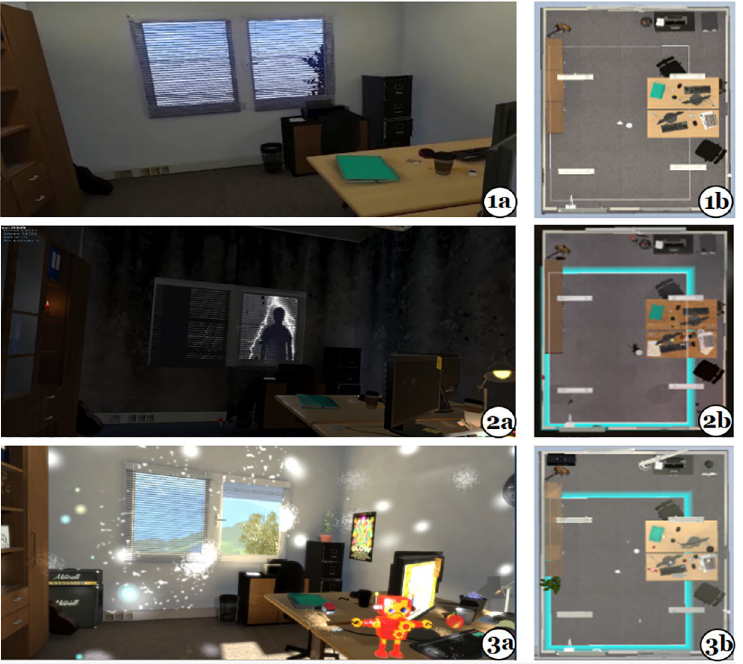
Fig 1. Screenshots of the three affective VEs from the user’s view (a, left side) and top view (b, right side). 1a & 1b (top): Neutral VE; 2a & 2b (middle): Negative VE; 3a &3b (bottom): Positive VE.